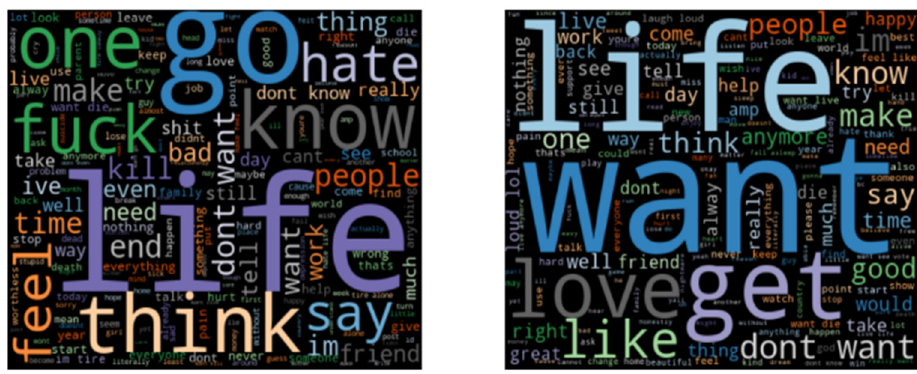
Figure 4. WordCloud of suicidal and non-suicidal tweets.